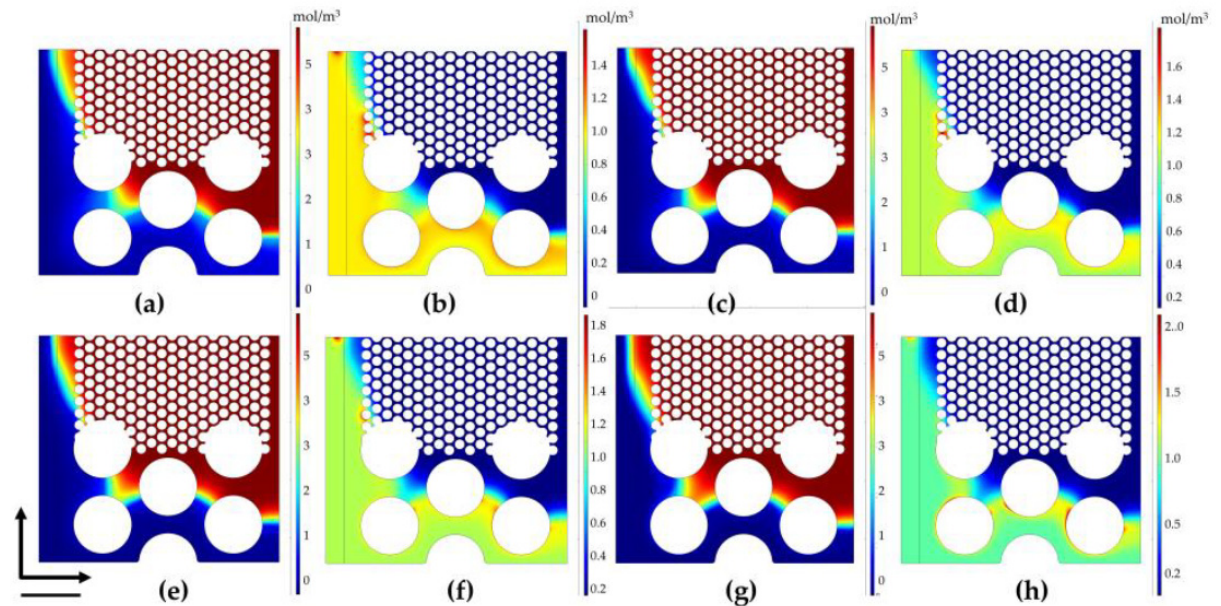
Figure 9. Distribution of toluene concentration (left) and bacteria concentration at different flow rates at the proposed steady state. The scale bar is 1 mm; ( a , c , e , g ) are the distribution of toluene concentration at the proposed steady state with inlet velocities of 1.13, 2.26, 4.52 and 6.78 m/d, respectively; ( b , d , f , h ) are the distribution of chemotactic bacteria concentration at the proposed steady state with inlet velocities of 1.13, 2.26, 4.52 and 6.78 m/d, respectively. In this figure, the numbers to the left of the colored bars are in mol/m 3 .